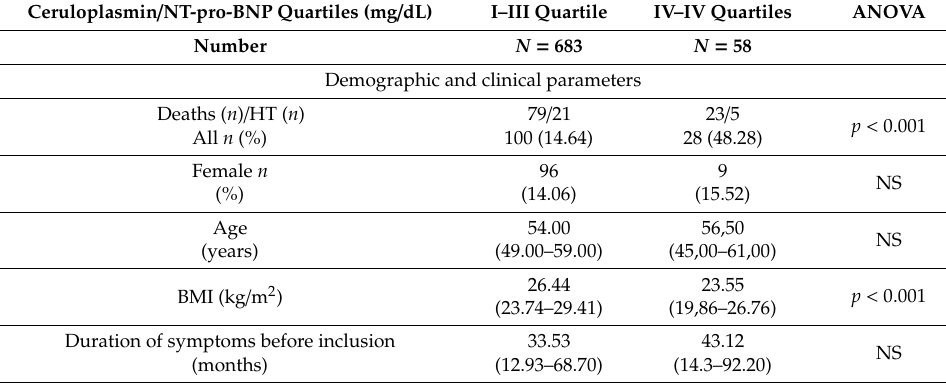
concentration quartiles are presented in Table 2 Table 2. Characteristic of examined group with division according to ceruloplasmin and N-terminal pro-B-type natriuretic peptide (NT-proBNP)